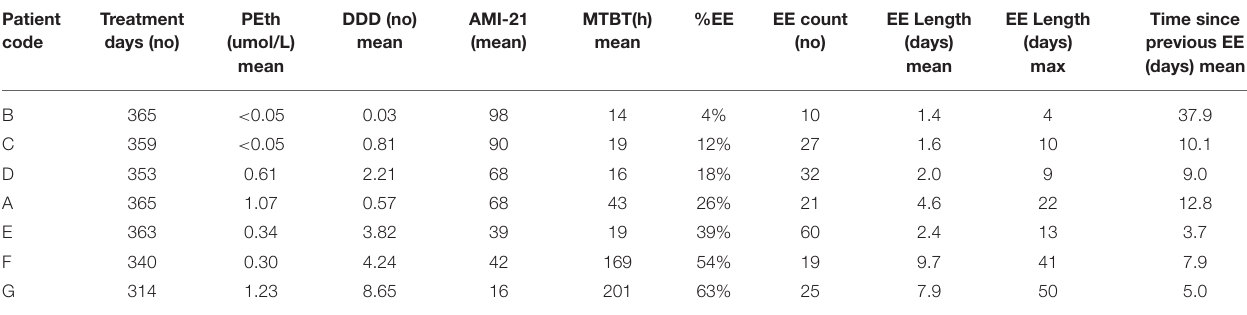
TABLE 1 | Background characteristics and exacerbation event data for 7 patients. Patient code